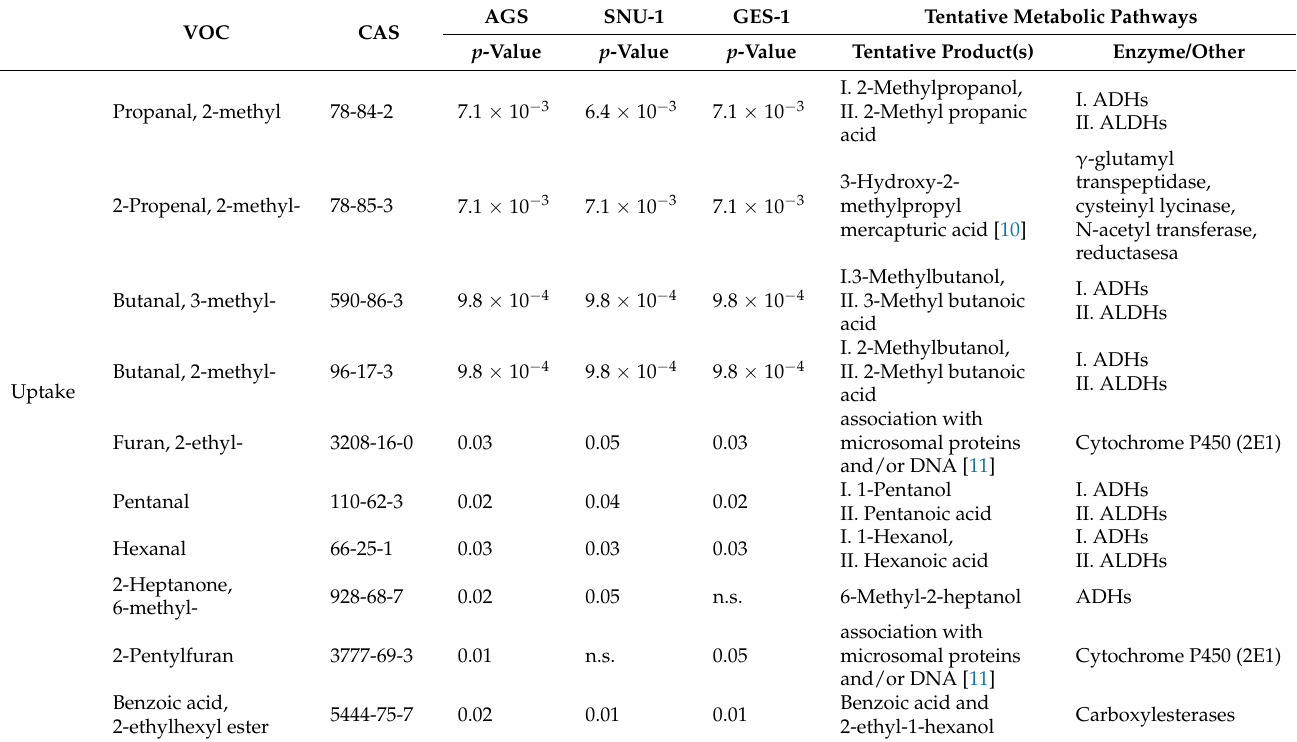
Table 4. Consumption and emission of VOCs by AGS, SNU-1, and GES-1 cells related to the medium only and tentative metabolic pathways of their production. p -values refer to the Wilcoxon signed-rank test. Compounds in italics were not quantified for reasons mentioned in the text. n.s.: not